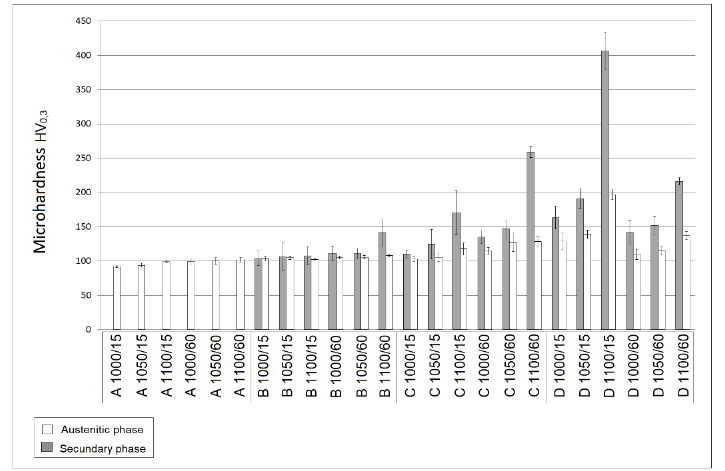
Fig. 10. Average microhardness values of all samples